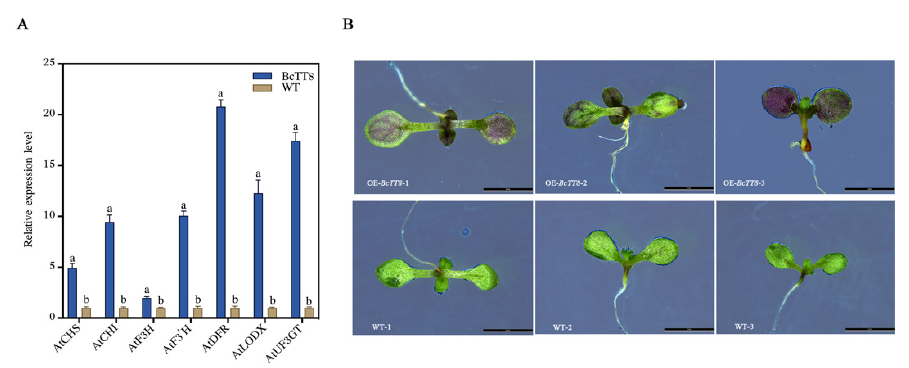
Figure 8. Identification of BcTT8 transgenic plants. RT-qPCR analysis of anthocyanin pathway genes in BcTT8 -overexpression plants ( A ) and photographs of WT and BcTT8 transgenic plants taken by stereoscopic microscope, bars = 5 mm ( B ).